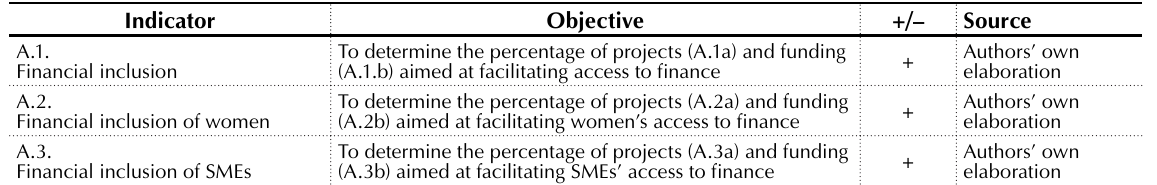
Table 2. Indicators of the level of financial inclusion in the development objectives of the projects